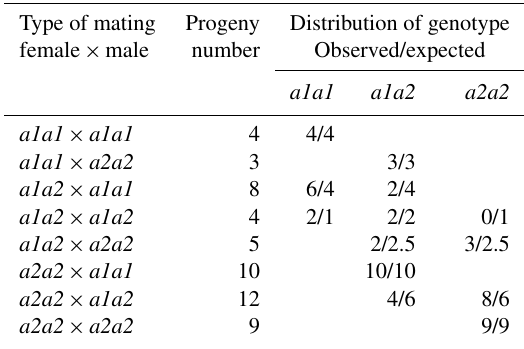
Table 2. The distribution of histone H1.a genotypes in the offspring of differently crossed quail individuals.